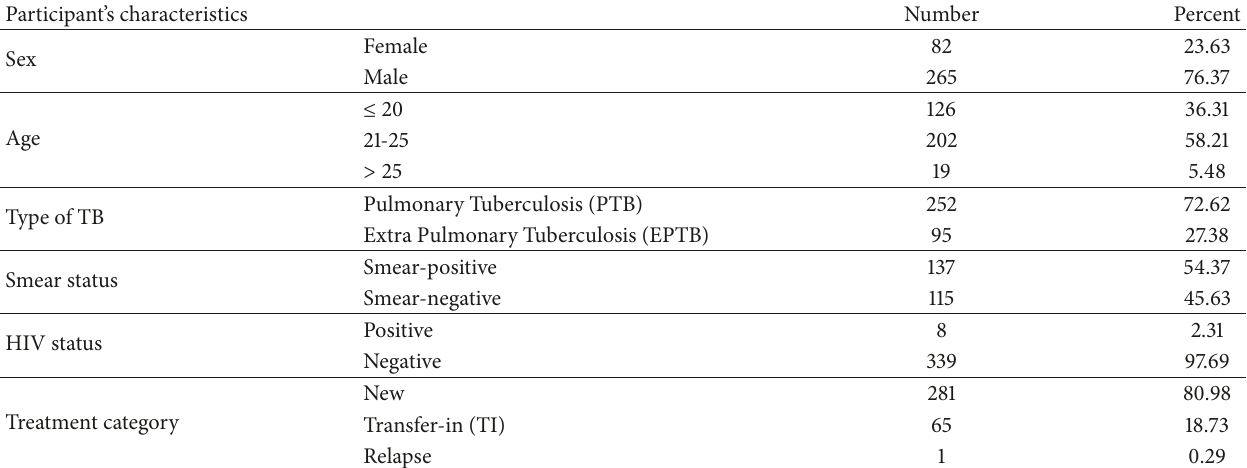
Table 1: Characteristics of study participants, JUMC, 11 Sep. 2010-10 Sep.